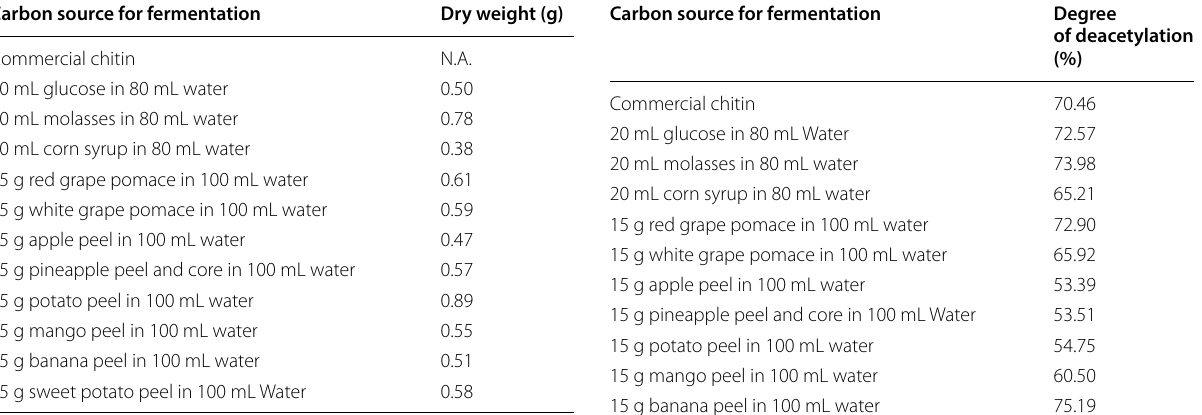
Table 1 Dry weight of chitin extracted after fermentation on various carbon sources Carbon source for fermentation Dry weight (g) Commercial chitin